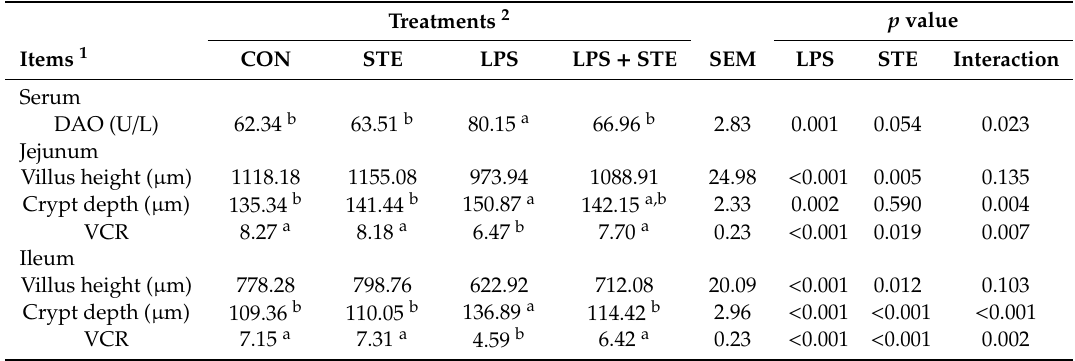
Table 4. E ff ects of stevioside supplementation on serum diamine oxidase activity and intestinal morphology of LPS-challenged